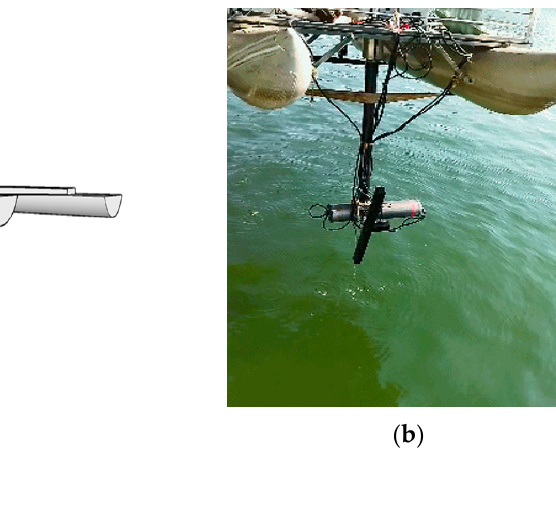
( d ) Figure 8. Experimental scenario and setup of circular array synthetic aperture sonar. ( a ) The sche- matic of CASAS installation in USV. It also shows the Navigation devices of USV, such as RTK GPS and INS. ( b ) The photo shows that the CASAS was installed in USV and the transmit and receive array side of CASAS perpendicular to the movement direction of USV during the trial. ( c ) The photo of the steel cube which was treated as experiment target. ( d ) The trajectory of USV in experiment which was recorded by GPS. The experimental results are shown in Figure 9, which contain the 2D slice imaging of the steel cube bottom, the reconstruction in the height direction at angle bin = 200, and the 3D imaging of steel cube. Comparing Figure 9a,b to Figure 8c, we can see that the 2D slice image has been reconstructed well, for the steel cube bottom, the steel cube side, and the ball can be seen clearly. Comparing Figure 9c to Figure 8c, we can see that the steel cube target has been reconstructed very well, and the 3D image is similar to a real steel cube. The bottom of the lake was also shown in Figure 9c. Therefore, the experimental results demonstrate the 3D imaging ability of the proposed imaging model and the sparse recovery algorithm.